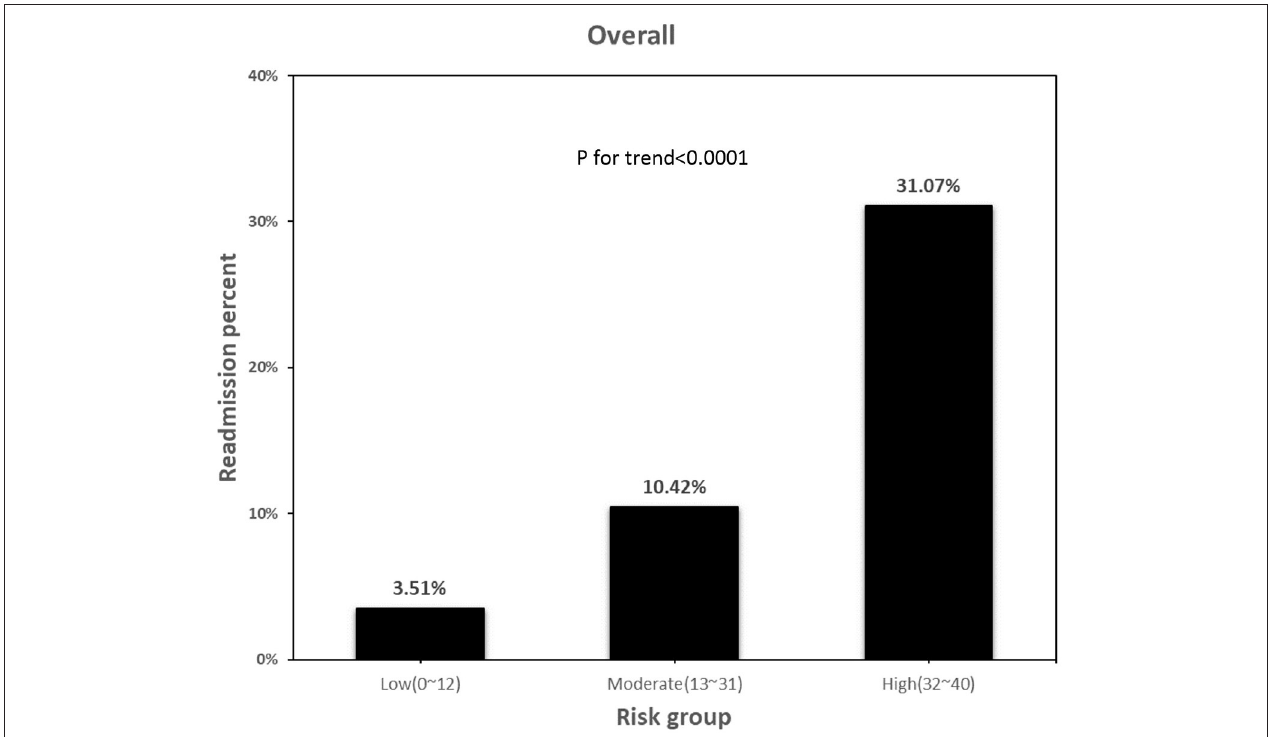
FIGURE 4 | Readmission percentage in different risk group. Readmission percentage between overall cohort regarding low (0–12), moderate (13–31), high risk group (32–40). P for trend < 0.0001 between 3